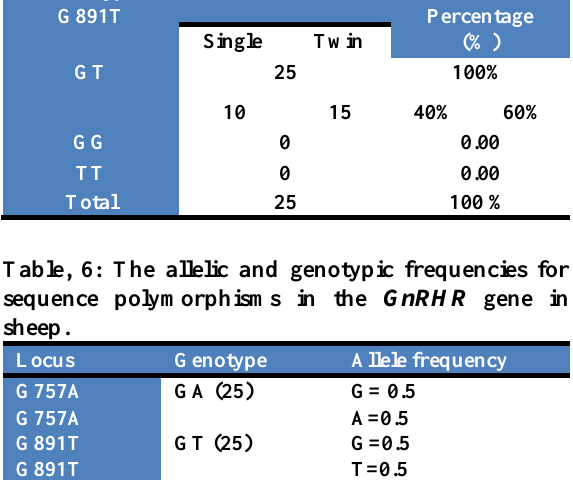
Table, 5: Distribution of genotype G891T according of type of offspring (No. and %) in sheep. Genotype